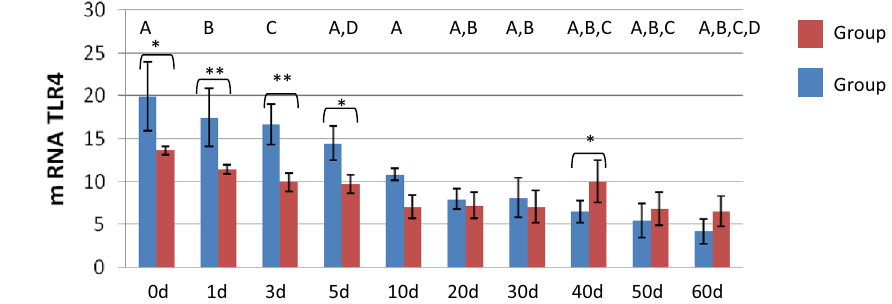
Figure 1. Trends in changes of TLR4 gene expression after immunization. 0d—sample collected at delivery; 1d—sample collected 24h after delivery; 3d—sample collected 3rd days after delivery; 5d—sample collected 5th days after delivery; 10g—sample collected 10th days after delivery; 20d—sample collected 20th days after delivery; 30d—sample collected 30th days after delivery; 40d—sample collected 40th days after delivery; 50d— sample collected 50th days after delivery; 60d—sample collected 60th days after delivery. Means are reported with their standard errors Group C—control group; Group E—experimental group stimulated multi-component bacterial immunomodulator (injection in 35th and 40th days after delivery). *Means in row/line for receptor show significant differences ( p <0,05). **Means in row/line for receptor show highly significant statistical differences ( p <0,01). Means for control group with same letter show highly statistical significant difference ( p < 0.01).